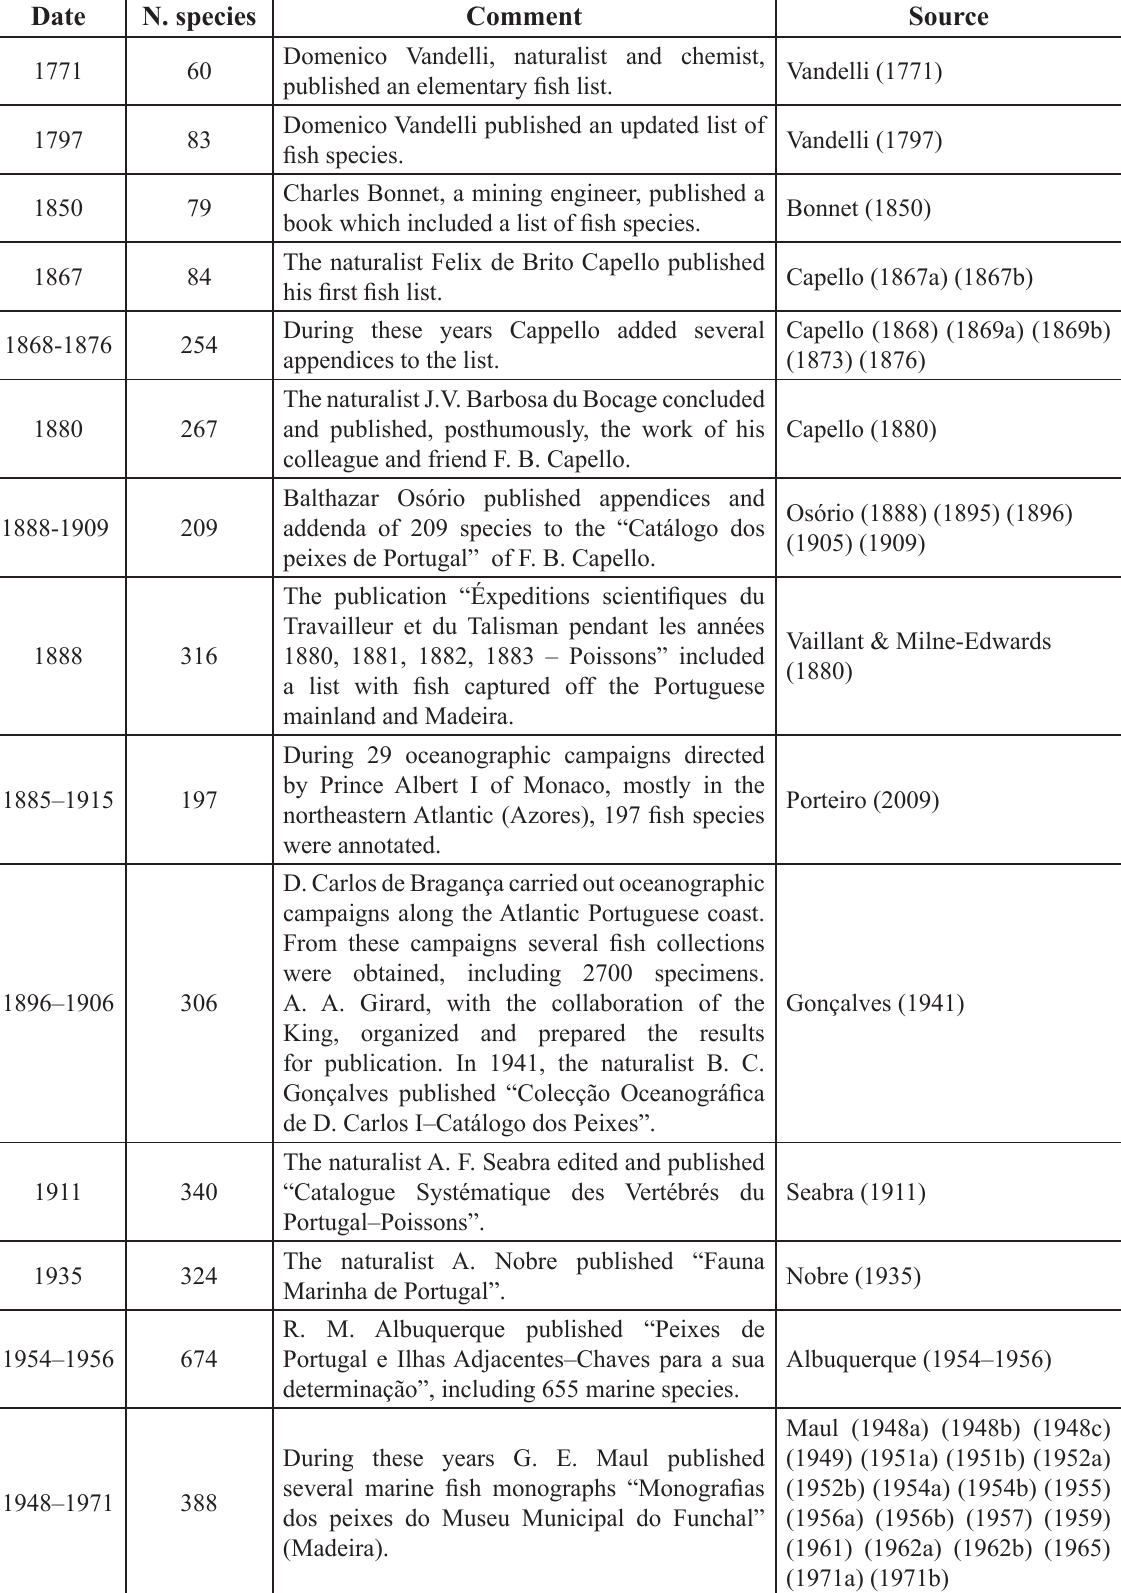
Table 1. Annotated list of historical publications reporting on marine fish species from